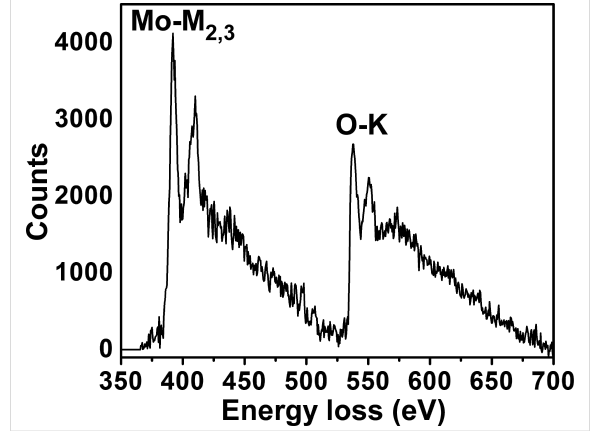
Figure 7: EELS spectrum of resultant h-MoO 3